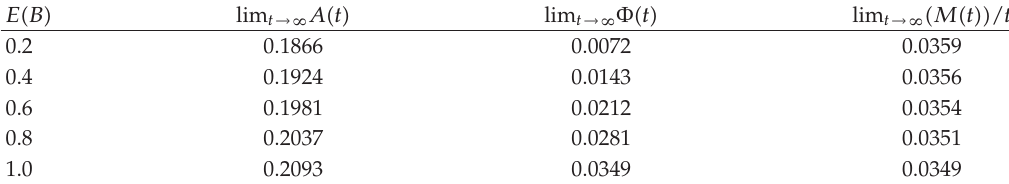
Table 3: Reliability indices for varying value of E (cid:2) B (cid:5) with (cid:2) E (cid:2) Y (cid:5) ,α (cid:5) (cid:8) (cid:2) 0.5, 0.2 (cid:5)